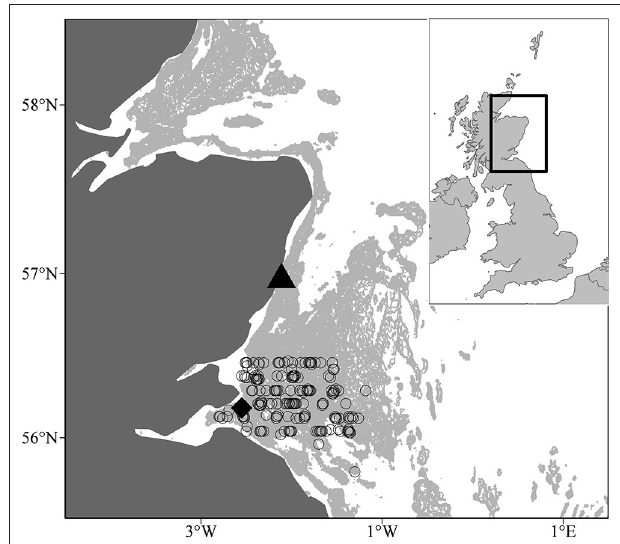
FIGURE 1 | Location of larval (black traingle, 56 ◦ 57.83 ′ N, 002 ◦ 06.74 ′ W) and juvenile and adult sampling (open circles) sites off the Scottish east coast. The black diamond denotes the Isle of May seabird colony. The pale grey shaded area indicates water depths between 30 and 70m, the range of depth sandeels are most commonly found (Wright et al., 2000), and marks out the three main sandbanks, Wee Bankie, Marr Bank, and Berwick’s Bank.